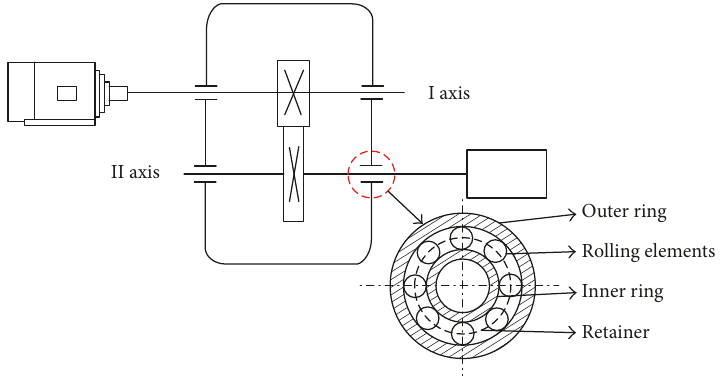
Figure 1: Physical structure of rolling bearing.